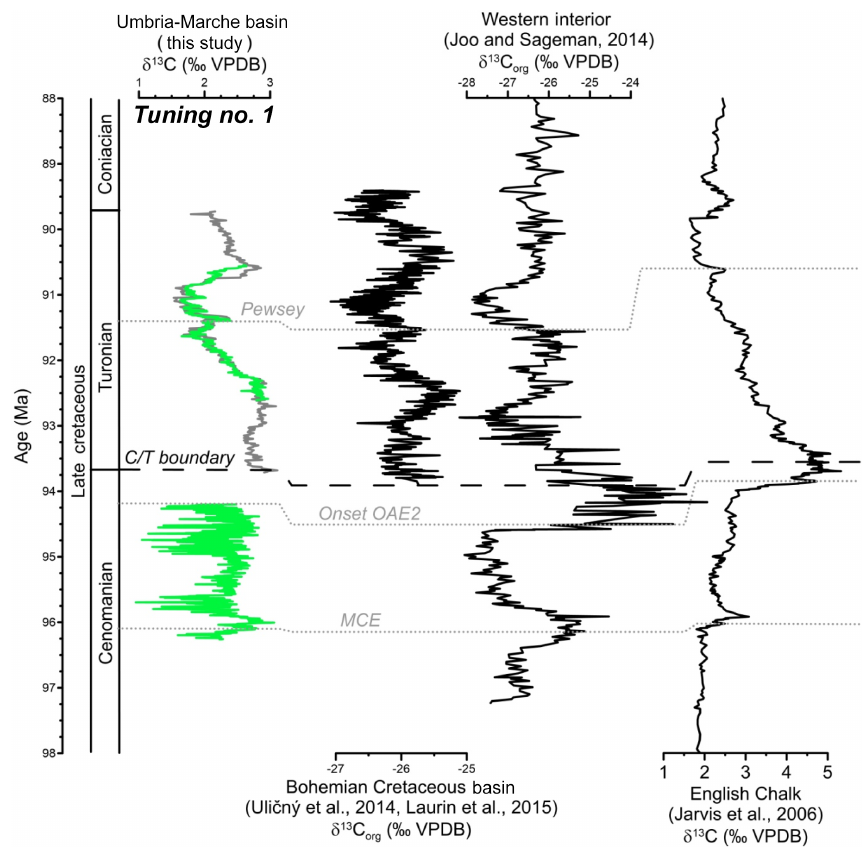
Figure 9. Global correlation of δ 13 C carb data of the Cenomanian–Turonian